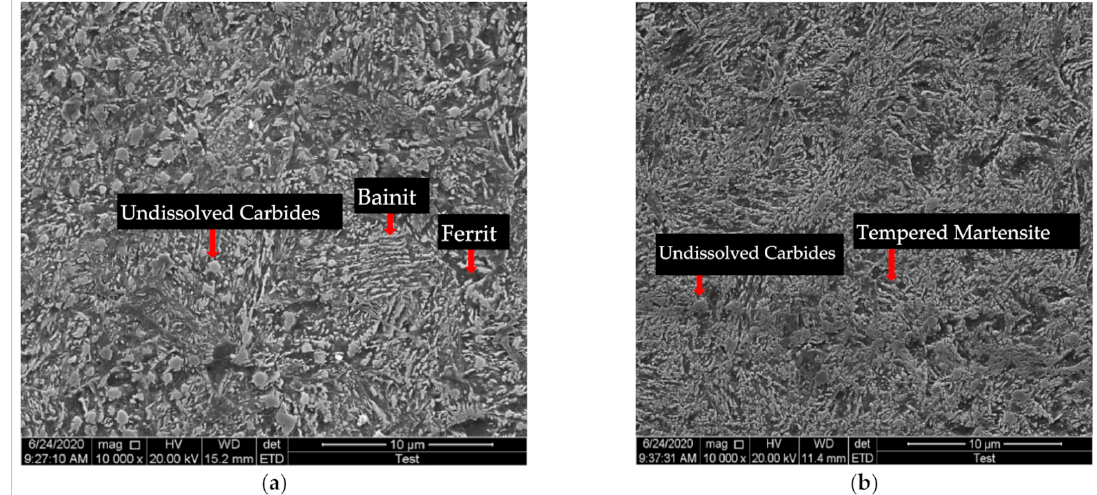
Figure 4. SEM images of microstructure of AISI6150 steel: ( a ) 343 ◦ C austempered disks, ( b ) 585 ◦ C quenched-tempered disks.